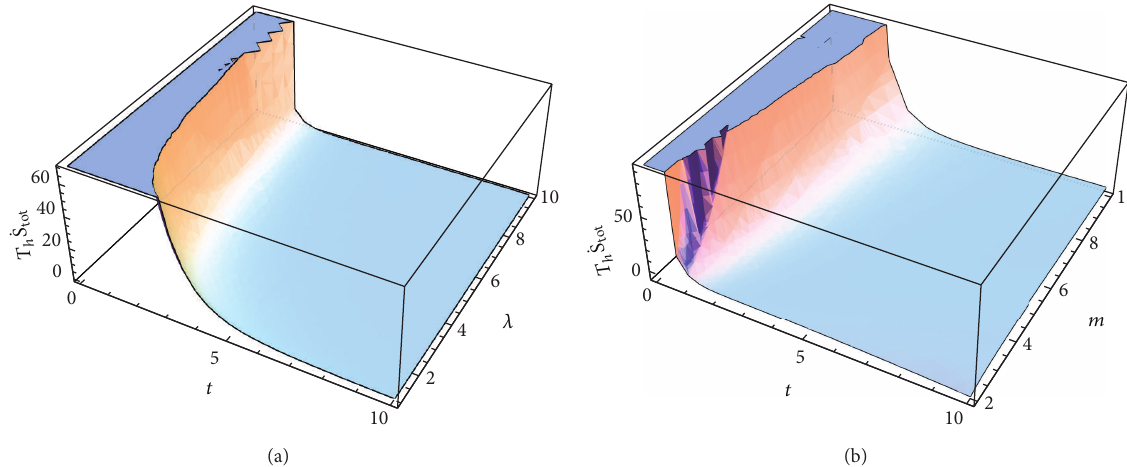
Figure 1: Evolution of GSLT for the Lagrangian 𝑓(𝑅,𝐿 𝑚 ) = 𝜆 exp ((1/2𝜆)𝑅 + (1/𝜆)𝐿 𝑚 ) , plot (a) shows the bound on parameter 𝜆 for 𝑚 = 10 , whereas in plot (b) we set 𝜆 = 2 to find bounds on 𝑚 . It is evident that GSLT is valid if 𝜆 > 0 , 𝑚 > 1 .